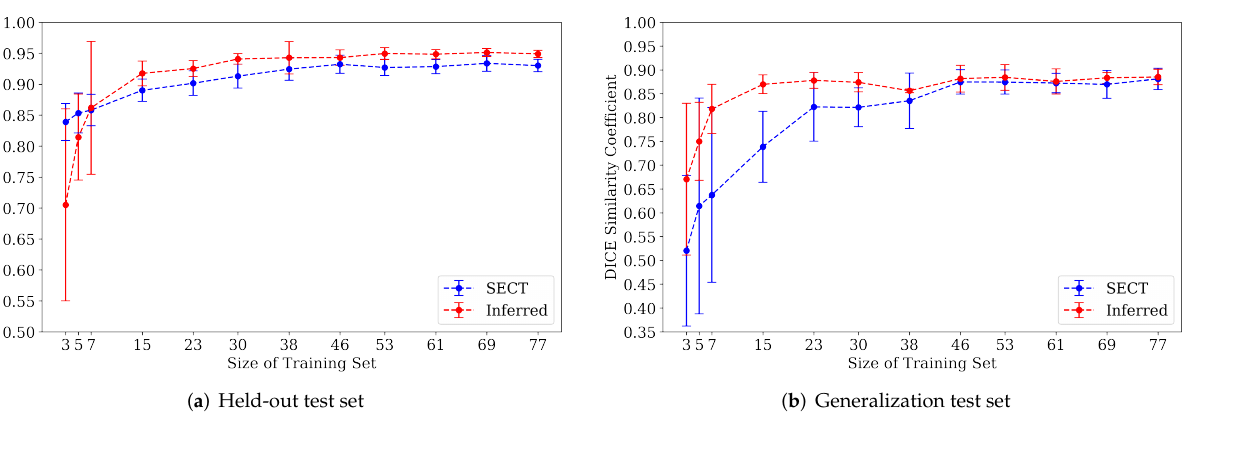
Figure 4. Comparison of segmentation accuracy (DICE) of liver vs. training set size. Average and standard deviation of the DICE score across 5-fold cross validation runs for the ( a ) held-out and ( b ) generalization test